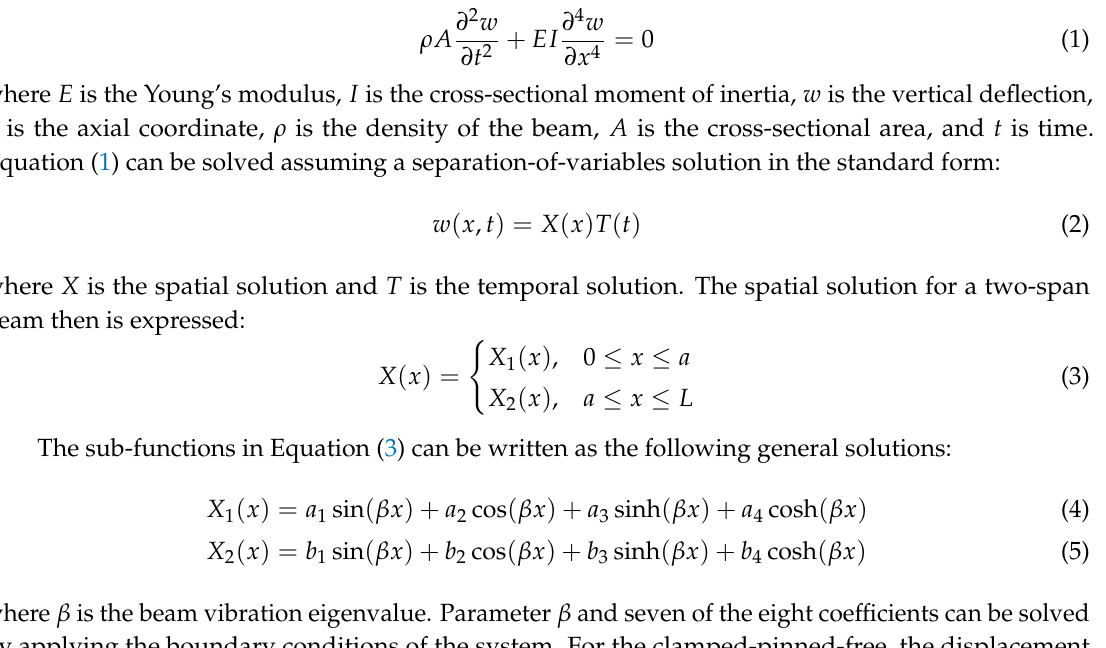
Figure 1. Schematic of a clamped-pinned-free beam with mass at free